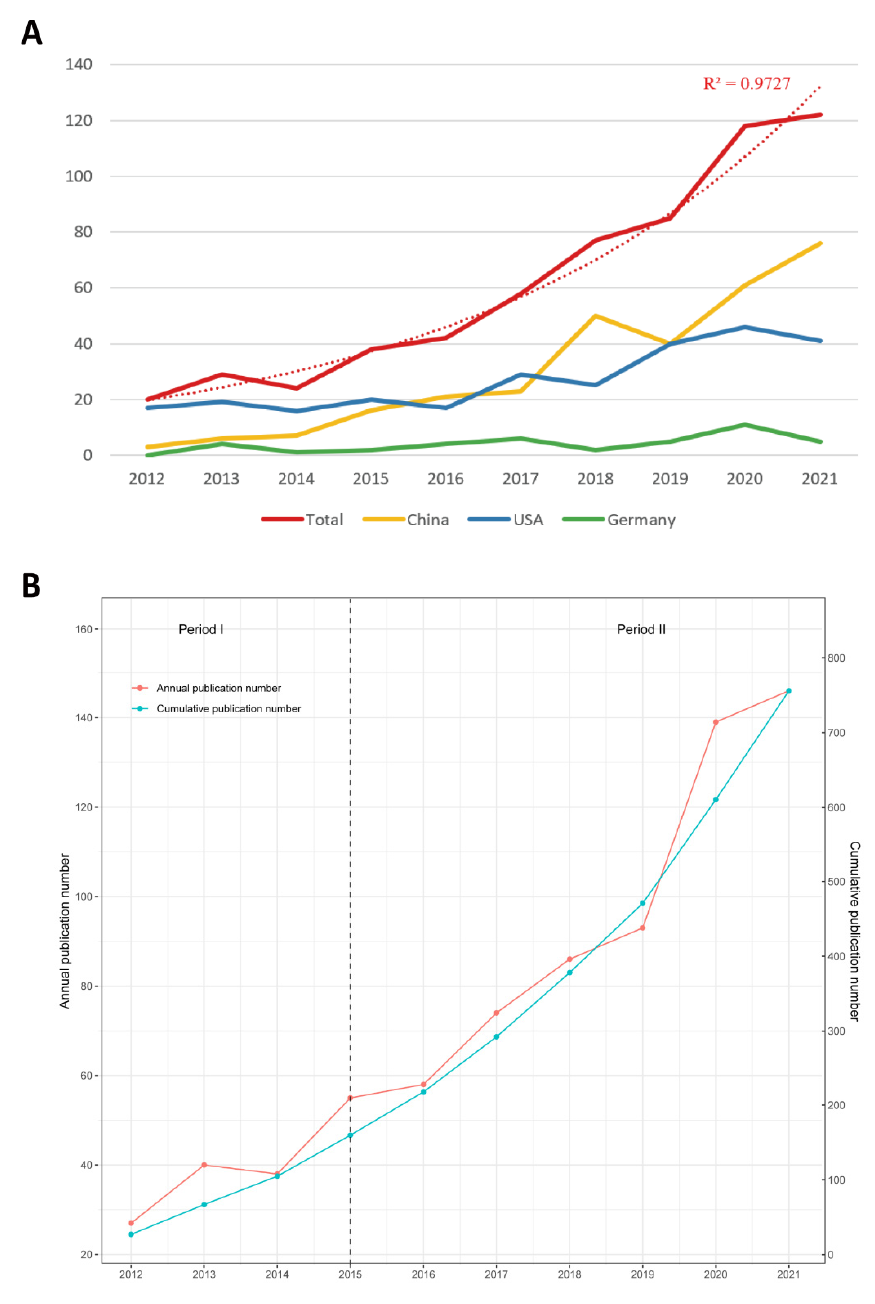
Figure 2. ( A ) The total numbers of publications and top three countries from 2012 to 2021. ( B ) The numbers of publications by year and accumulation from 2012 to 2021.